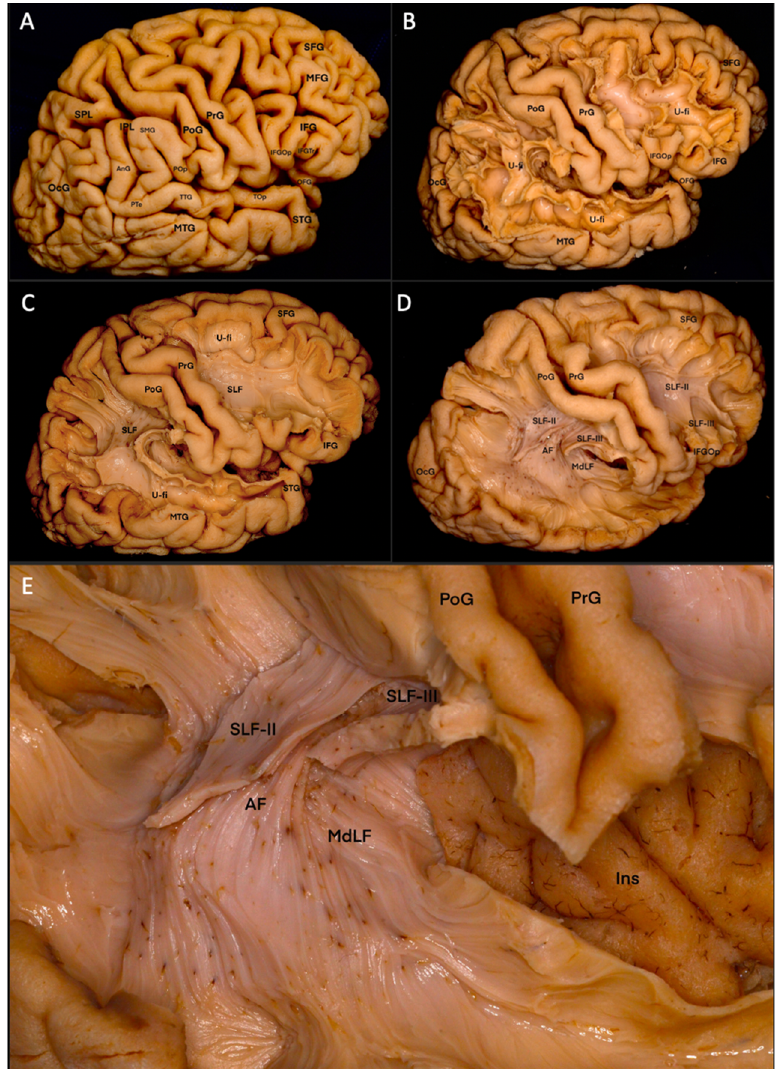
Figure 1. ( A ): When we look at the lateral surface of the hemisphere of the brain, AnG, SMG, PrG, PoG and surrounding anatomical structures appear. ( B ): View of U fibers after decorticating